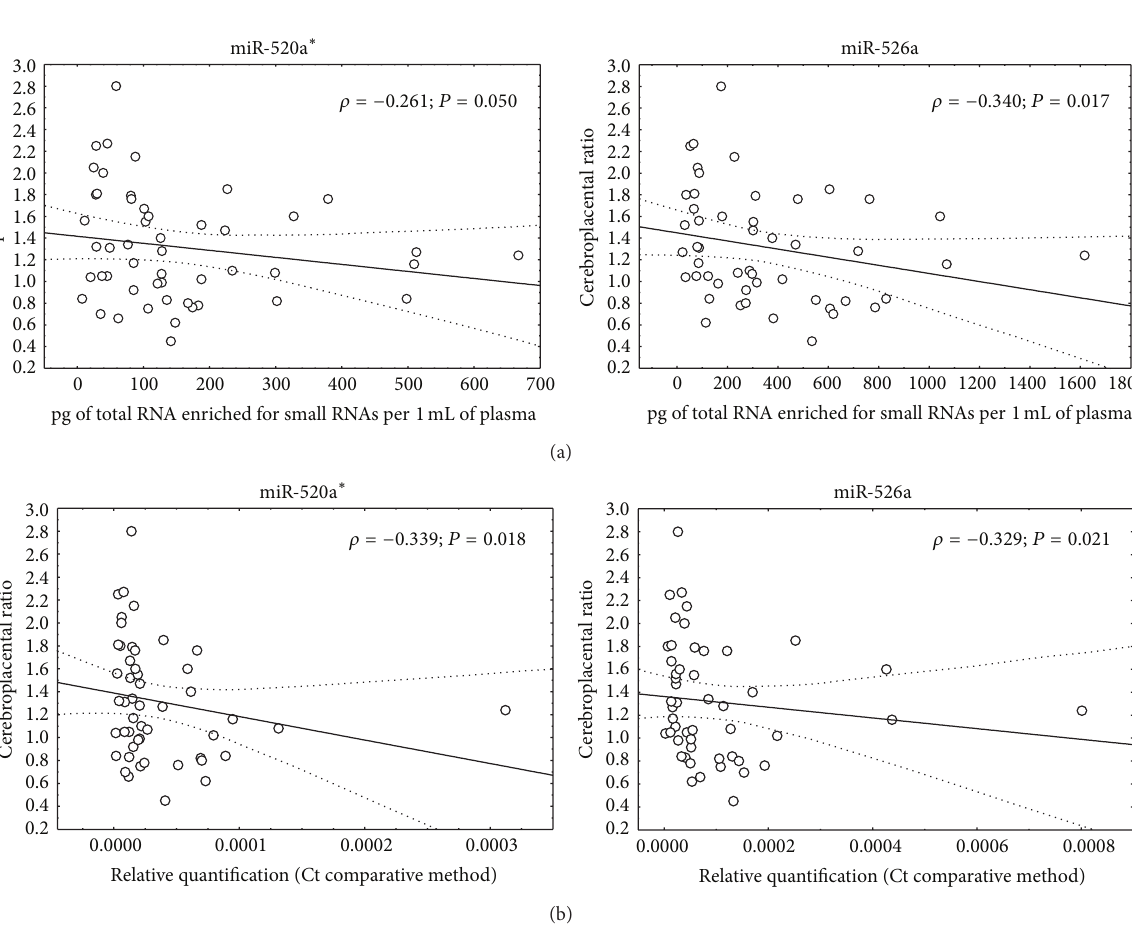
during the onset of preeclampsia w or w/o fetal growth restriction was